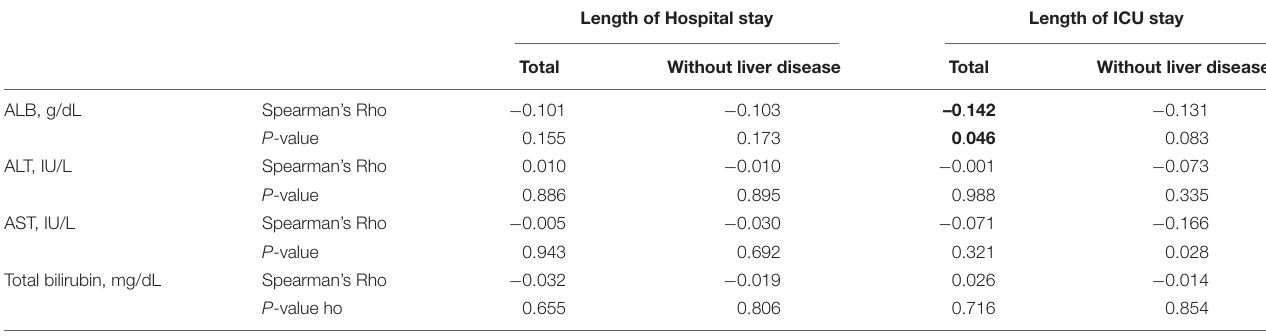
TABLE 2 | The correlation of ALB, ALT, AST, and total bilirubin with hospital stay and ICU stay.